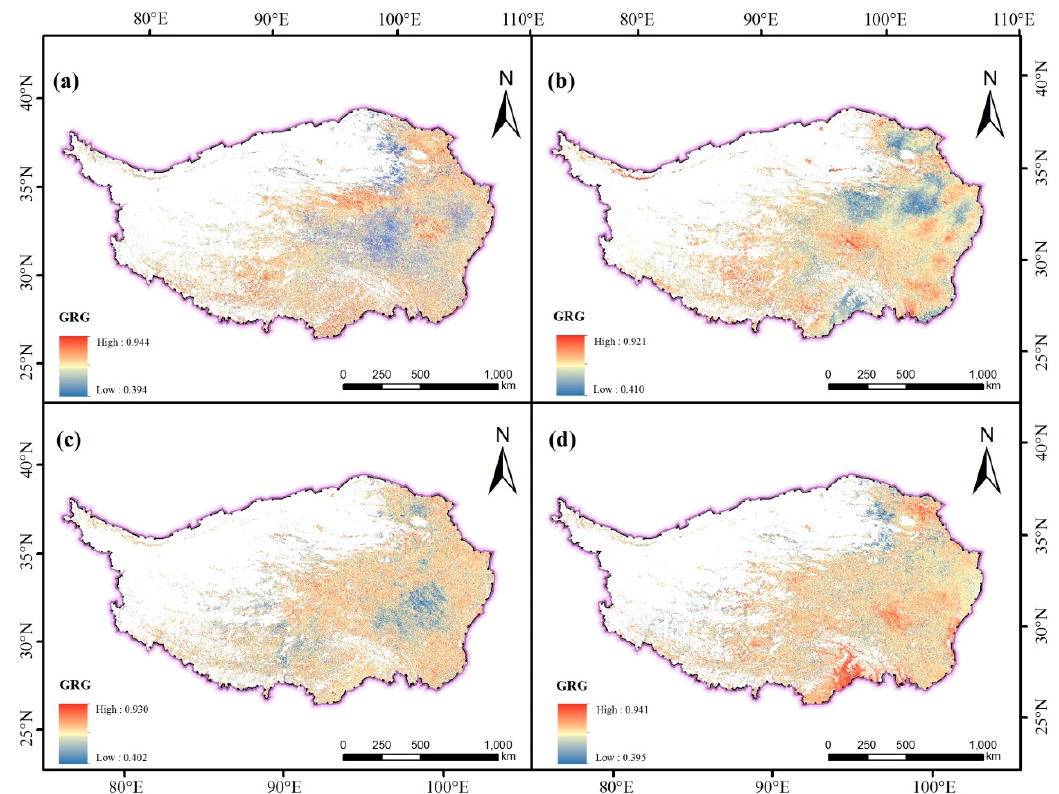
Figure 8. GRD between NDVI and air temperature ( a ), precipitation ( b ), relative humidity ( c ), and sunshine duration ( d ).